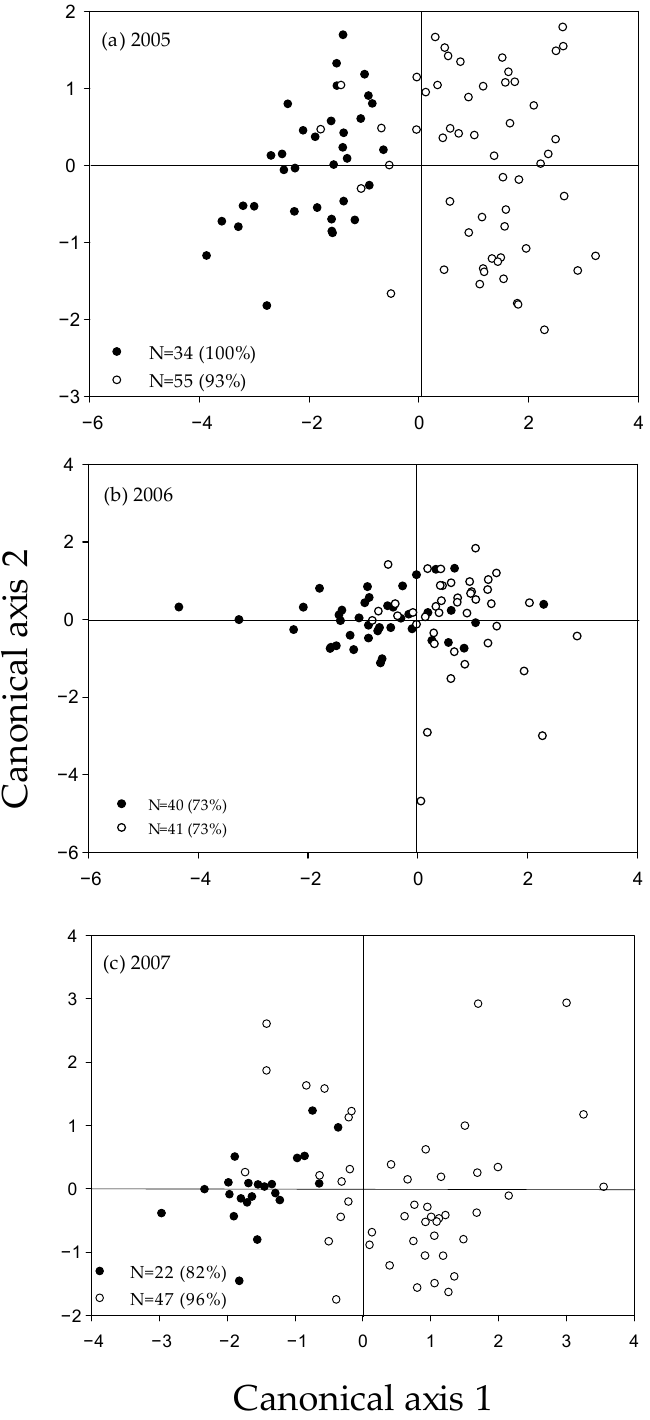
Figure 3. Canonical correlations of age-0 northern pike otolith isotopic concentrations collected in ( a ) 2005, ( b ) 2006, and ( c ) 2007 from Stagecoach Reservoir (closed circles) and Lake Catamount (open circles), Colorado, USA. The legend indicates sample size and correct classification percent for each year. Isotopic concentrations analyzed included barium ( 137 Ba), strontium ( 86 Sr), and manganese ( 55 Mn).